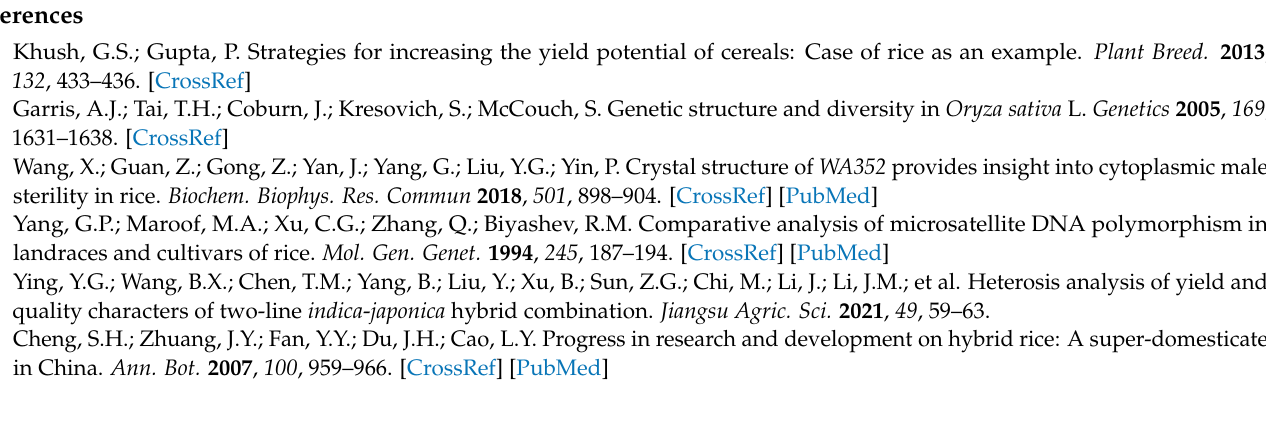
with the HJX74 SSSL 10-06; Figure S7: Phenotype of HJX74-SSSL 10-06 as control and two ORF4 gene edited mutants E403-9 and E403-12 in T 2 generation, and ORF4 over-expression mutants E 343 and E342; Figure S8: Sequence alignment of the sgRNA target region amplified by marker ORF3 -G in six different ORF3 - ORF4 genes edited lines; Figure S9: Sequence alignment of the sgRNA target region amplified by marker ORF4 -G in six different ORF3 - ORF4 genes edited lines; Figure S10: Phenotype of HJX74-SSSL 14-06 as control and six ORF3 - ORF4 genes edited mutants in T 2 generation; Figure S11: Sequence alignment of the sgRNA target region amplified by marker ORF4 -G in three different ORF4 gene edited lines compared with the TISL-Dbc-Gde; Figure S12: Phenotype of TISL-Dbc-Gde as control and three ORF4 genes edited mutants in T 2 generation; Figure S13: Transcriptome analysis of the panicles of the hybrids from 04-06/10-06 and 14-06/10-06 (sterility) vs. 04-06/14-06 (fertility) at meiosis stage; Figure S14: The comparisons of key genes expressions between qRT-PCR and RNA-Seq data; Figure S15: Differentially expressed genes enriched GO categories and KEGG pathway (the spikelet of hybrids F 1 from 04-06/10-06 and 14-06/10-06 vs. 04-06/14-06 in Sp2 and Sp3 stage); Figure S16: Differentially expressed genes enriched KEGG pathway (the spikelet of hybrids F 1 from 04-06/10-06 vs. 14-06/10-06 in three development stage); Table S1: Genotype of ORF3 , ORF4 , and ORF5 at S5 locus for 38 parents used in diallel crosses; Table S2: Pollen fertility and spikelet fertility in hybrids F 1 and the F 2 distorted segregation of the S5 locus in a diallel set of crosses involving 38 parents (% ± SD, n = 10); Table S3: The spikelet fertility in hybrids F 1 from the crosses of indica -SSSLs with ORF4 + overexpression mutations or ORF4 + edited mutations in the japonica -SSSL 10-06 background; Table S4: The spikelet fertility in hybrids F 1 from the crosses of gene-edited mutations in the SSSL 14-06 background with HJX74-SSSL 10-06 or ORF4 -edited mutations in 10-06 background; Table S5: Sequencing data quality assessment and reads mapping with reference genome; Table S6: The differentially expressed genes in combination from 04-06/14-06 (fertility) and 04-06/10-06 or 14-06/10-06 (sterility) at meiosis stage; Table S7: The differentially expressed genes in combination from 04-06/14-06 (fertility) and 04-06/10-06 or 14-06/10-06 (sterility) at different period of immature inflorescences; Table S8: The differentially expressed genes in combination from 04-06/10-06 (low) and 14-06/10-06 (high) at different period of immature inflorescences; Table S9: Primer sequences used in this